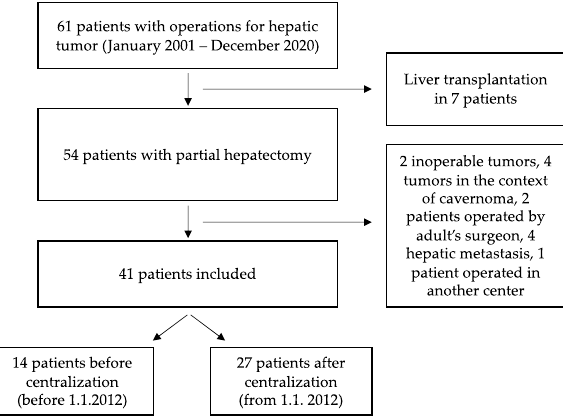
Figure 1. Flow-chart of included and excluded